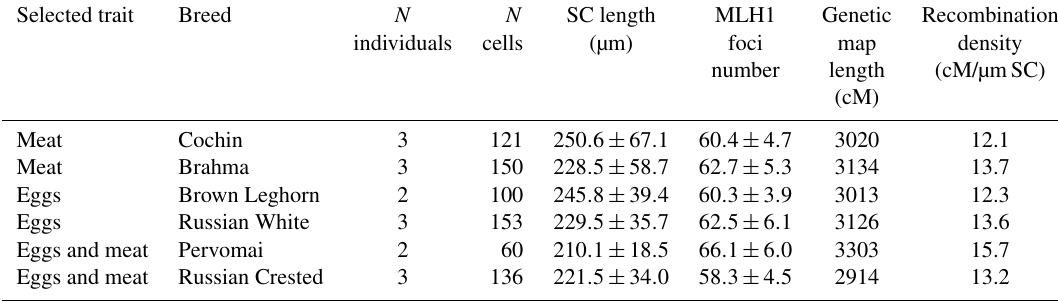
Table 1. Mean ( ± SD) length of synaptonemal complex and MLH1 focus number in the roosters of six breeds. Selected trait Breed N N SC length MLH1 Genetic Recombination individuals cells (µm) foci map density number length (cM/µmSC)